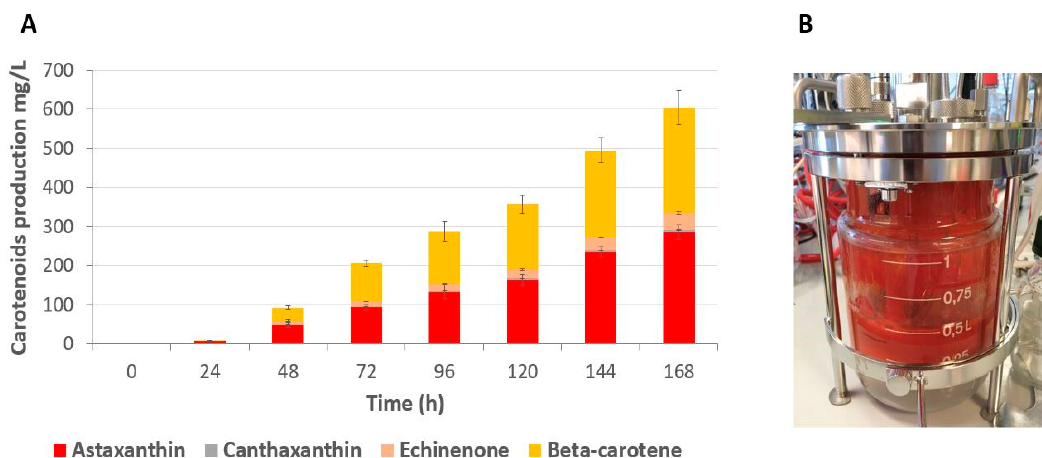
Figure 8. A: Carotenoid concentrations during fed-batch cultivations (as in Figure 7) of ST7976 (iso 3). 228 The values are averages from three independent experiments; the error bars represent show standard 229 deviations. B: Bioreactor at the end of the fed-batch fermentation of ST7976 (iso 3). 230